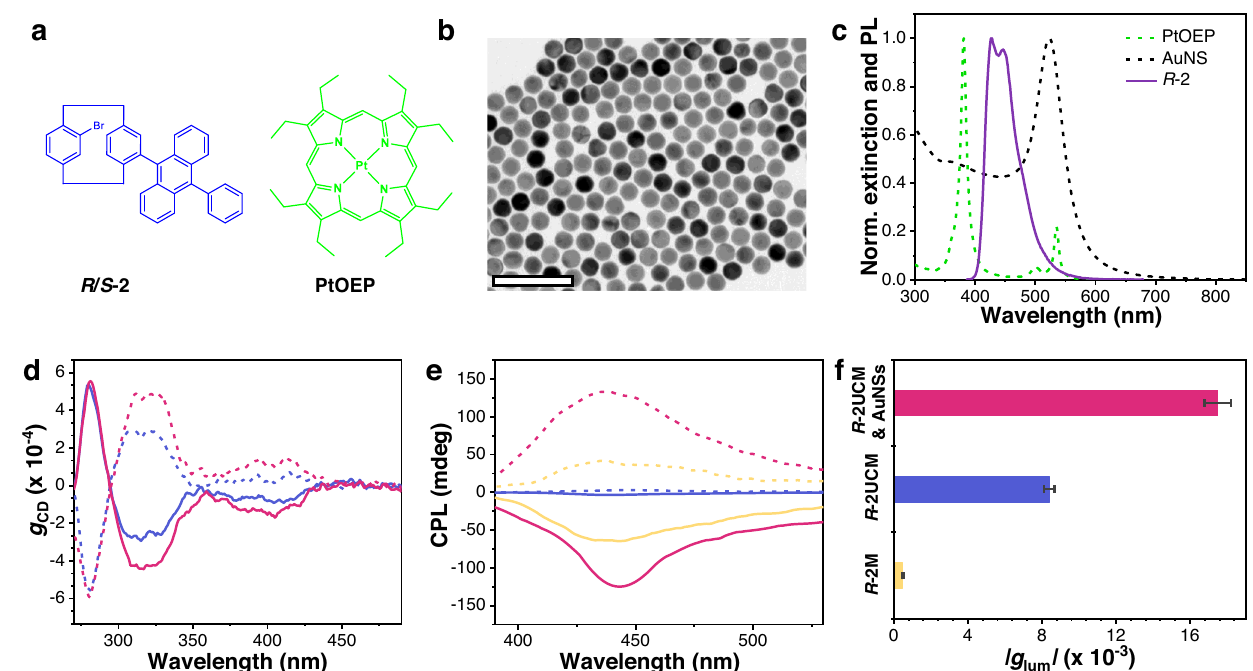
Fig. 5 | Extension of plasmonic fi eld enhancement effect in chiral emitter 2 systems. a Molecular structures of chiral emitters R / S -2 and sensitizer PtOEP. b TEMimageofAuNSs.Scalebar=100nm. c Normalizedextinction(dashline)and photoluminescence (solid line) spectra of PtOEP and R -2 in THF and AuNSs in water. λ ex =360nm. [ R -2]=[PtOEP]=10 − 5 molL − 1 , [AuNSs]=6.9×10 − 10 molL − 1 . d CDdissymmetryfactor g CD of R -2M(blueline), S -2M(bluedashline), R -2M/AuNSs (red line), and S -2M/AuNSs (red dash line) versus wavelength. e CPL spectra of R -